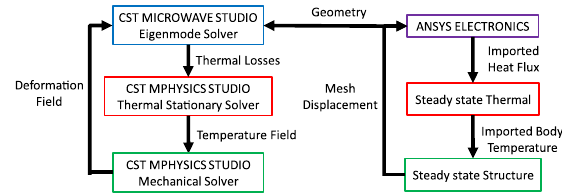
FIG. 26. The cooling channel